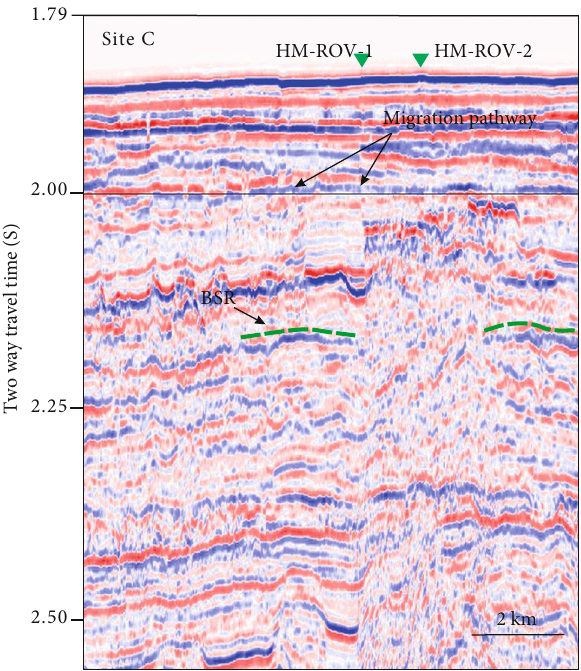
Figure 8: Seismic pro fi le of station C showing the slightly upward slope of the sea fl oor and the many well-developed migration pathways. The positions of HM-ROV-1 and HM-ROV-2 are